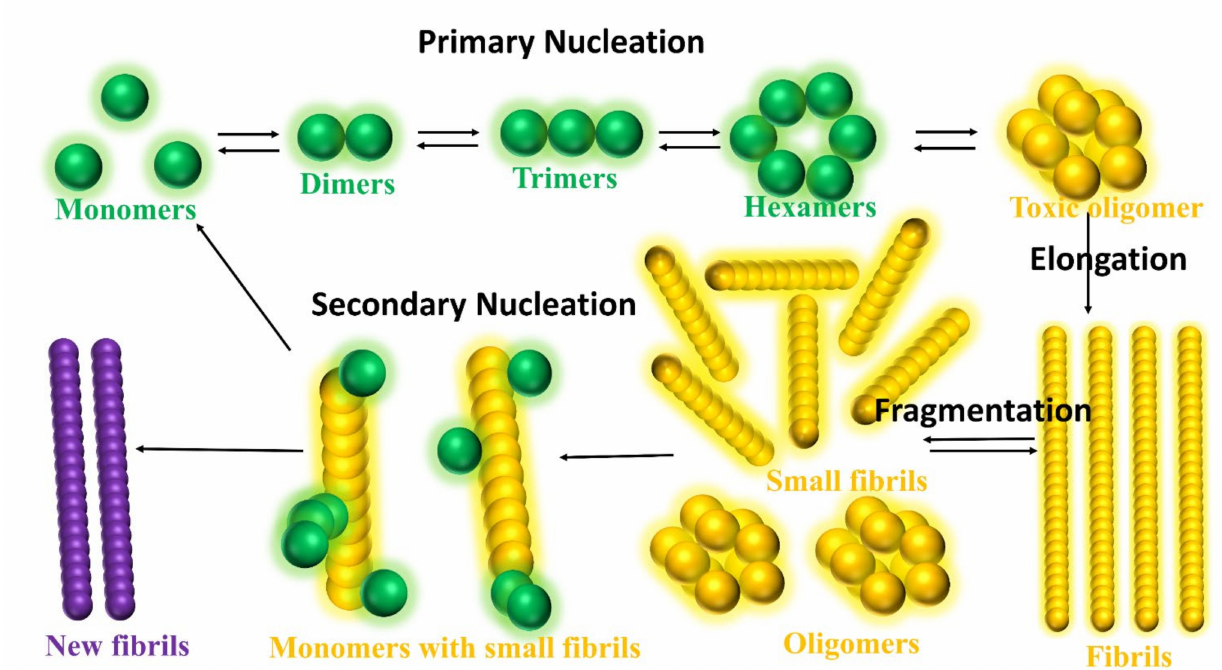
Figure 7. Schematic illustration of the aggregation pathways. There are characterized into four types: Primary nucleation, monomers formed dimers, trimers, hexamers and then oligomers. Elongation, the oligomers are joined together to generated the fibrils. Fragmentations, the fibrils break into the number of small fibrils and oligomers. Secondary nucleation, only minority of small fibrils convert into a new fibril by adding monomers, but due to the addition of monomers, the majority of the small fibrils turn into the monomers or